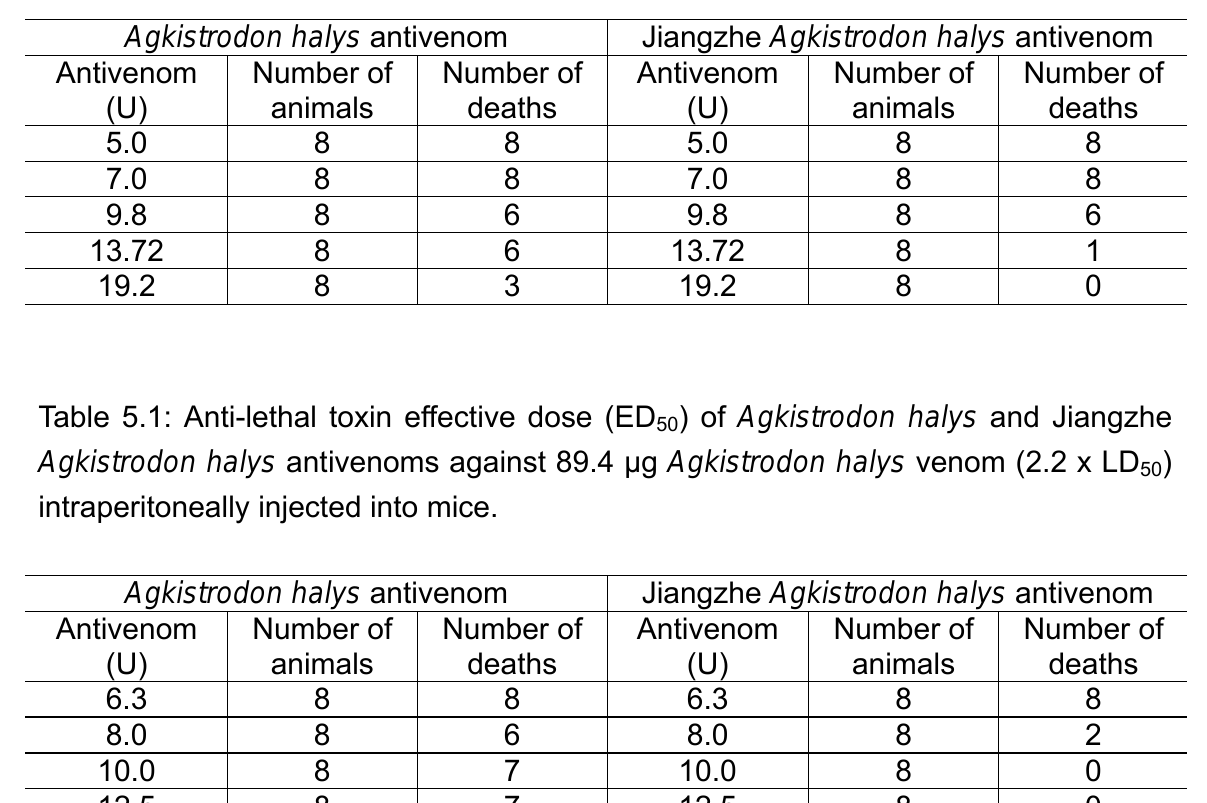
Table 4.2: Anti-lethal toxin effective dose (ED Agkistrodon halys antivenoms against 93.9 µg Jiangzhe Agkistrodon halys venom (2.4 x LD ) intravenously injected into mice. 50